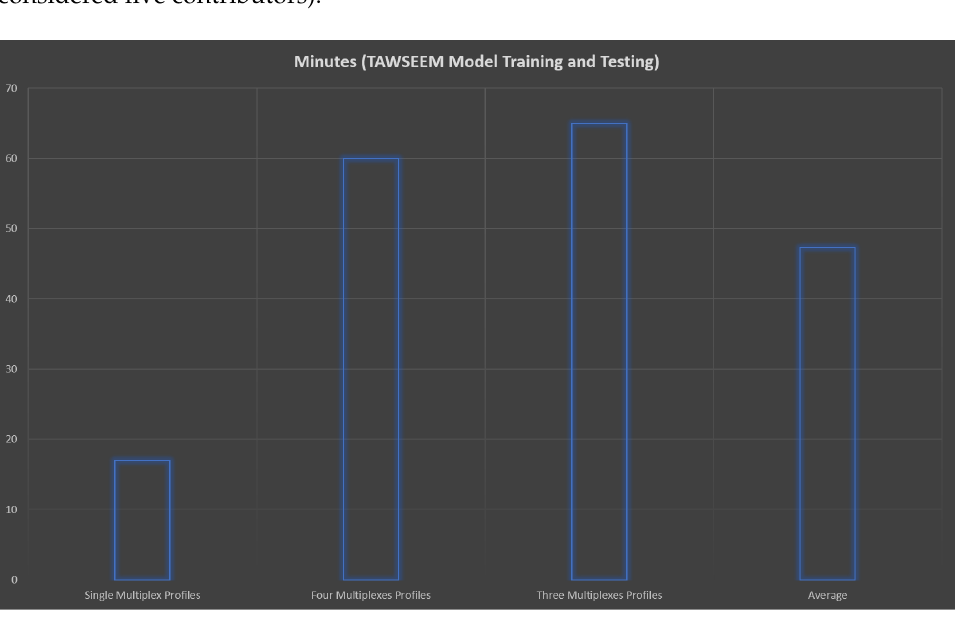
Figure 30. TAWSEEM: execution